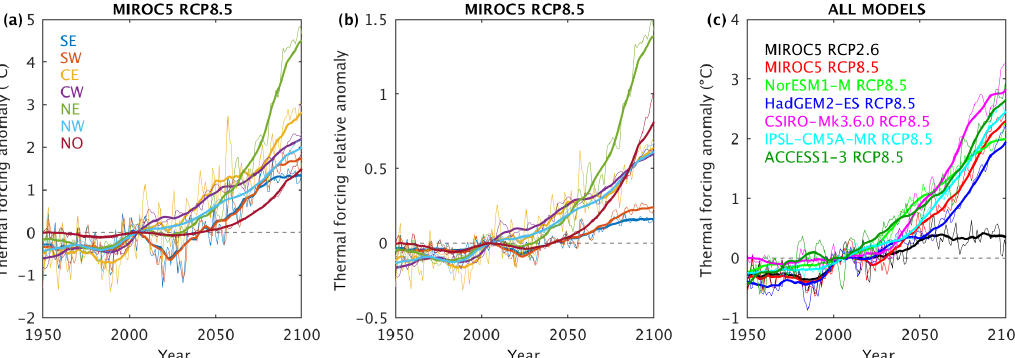
Figure 8. Projected 200–500m ocean thermal forcing. (a) Projected absolute thermal forcing anomaly per ice–ocean sector in the MIROC5 RCP8.5 simulation. (b) Thermal forcing anomaly normalised by the present-day value. The legend is the same as for (a) . (c) Mean thermal forcing over the seven ice–ocean sectors for each CMIP AOGCM. Full plots for all sectors and all models may be found in Figs. S6 and